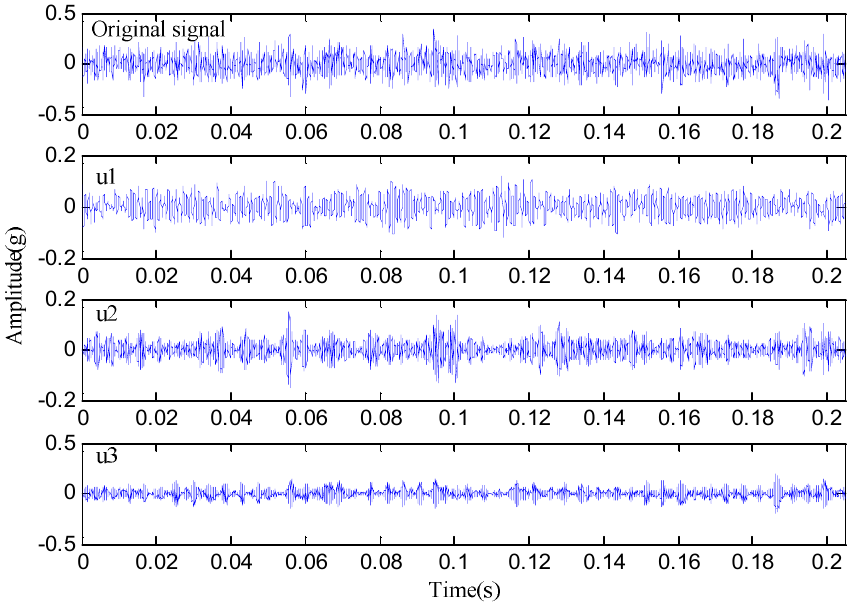
Figure 6. The case signal and decomposition results by FE guided-VMD.